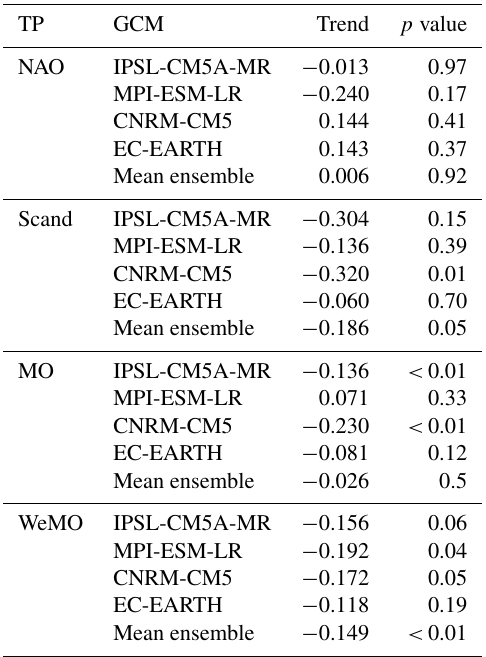
Table 3. Linear trends for the annual teleconnection patterns during the period 2006–2100 and under a RCP8.5 scenario. Results are shown for each individual GCM as well as for the mean ensemble of all of